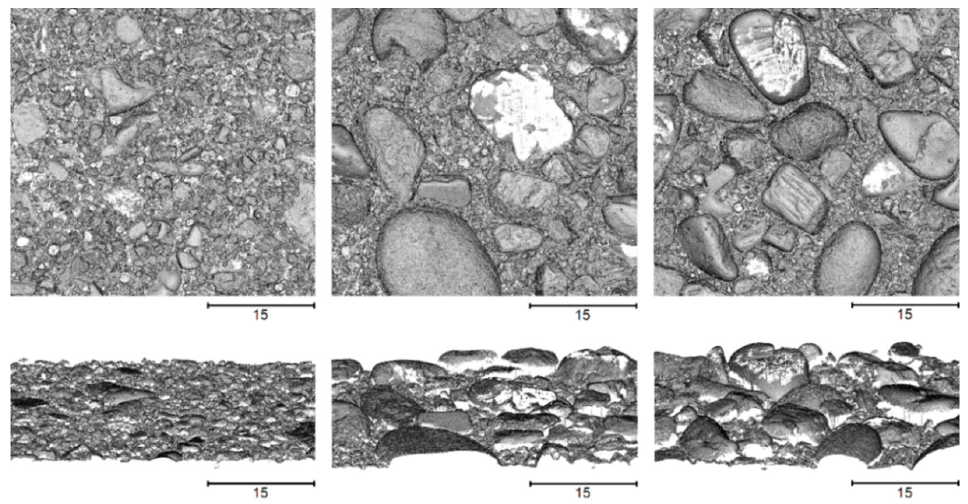
Figure 7. Captured surface meshes of the three specimens using the microscope system, in top and oblique view—to the left specimen 1, in the center specimen 2 and to the right specimen 3.